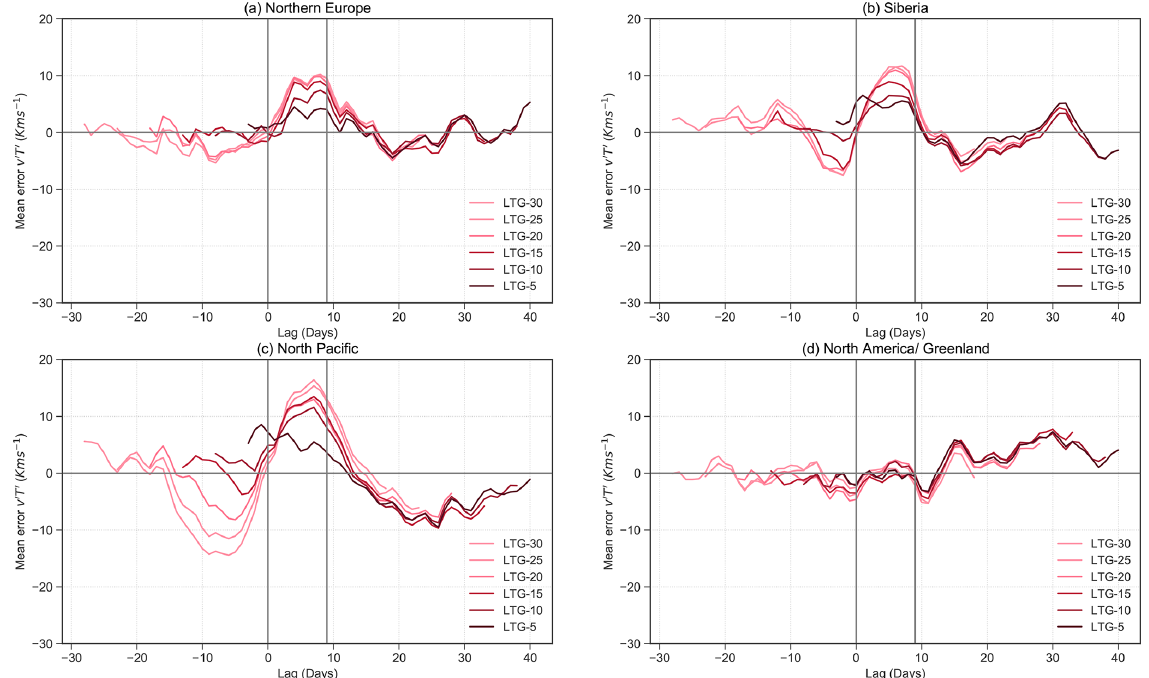
Figure A6. Same as Fig. A5 but for acceleration